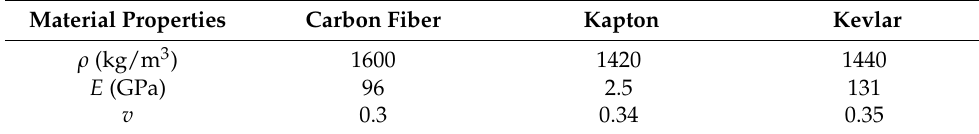
Figure 6. ( a ) FE model of space membrane deployable mechanism. ( b ) Zoomed-in view of the STEM. ( c ) Tensions and fixed support. Table 2. Material